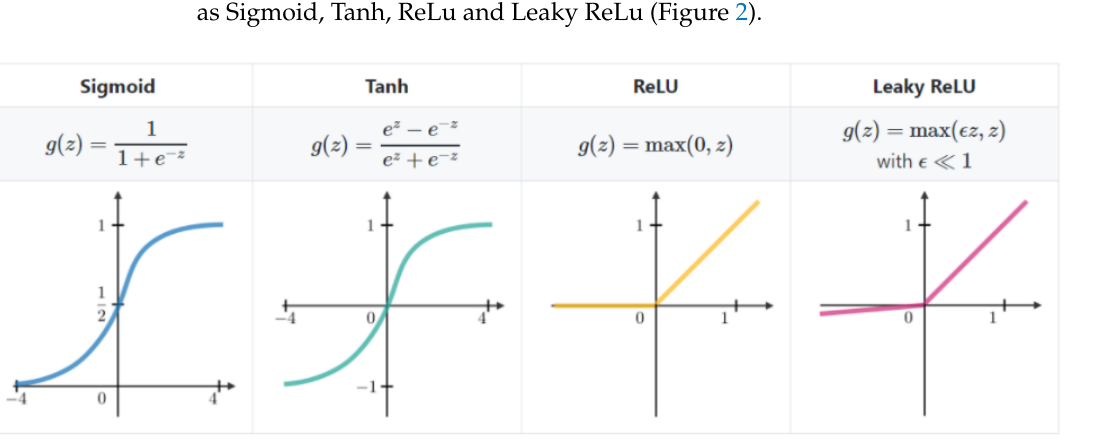
Figure 2. Activation